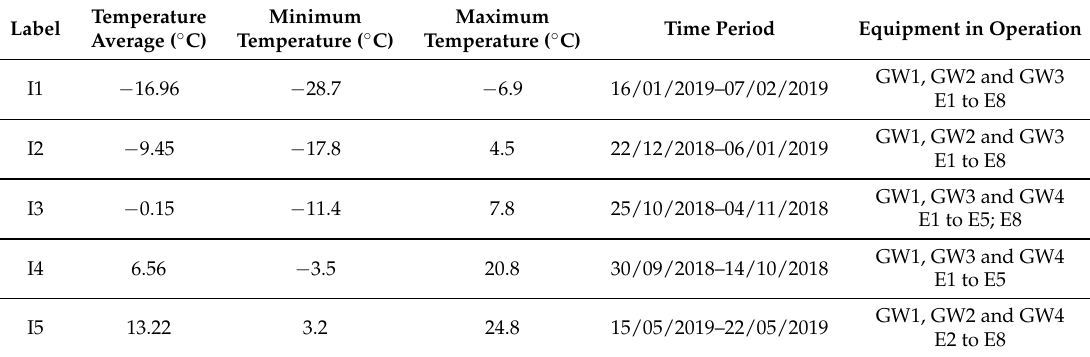
Table 7. Periods and temperature average of our evaluations.